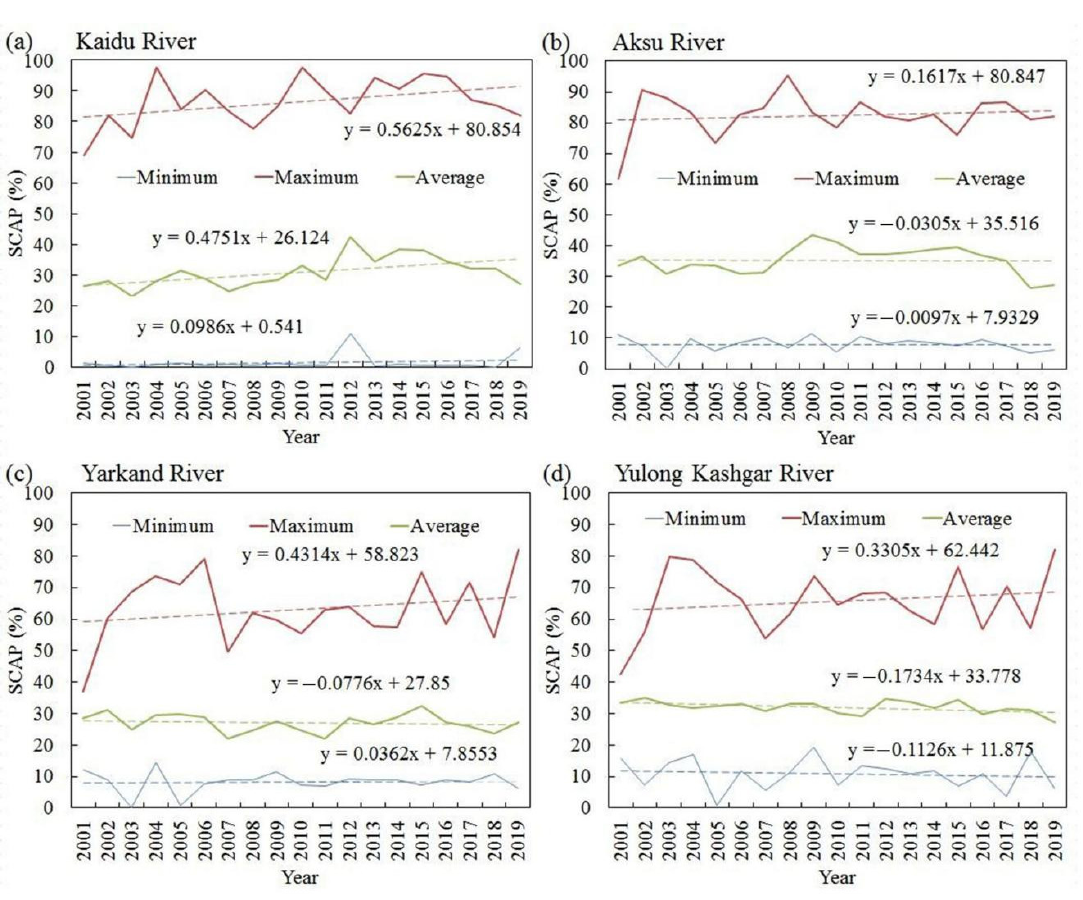
Figure 5. Variations of maximum, average, and minimum SCAP in the Tarim River Basin during 2001–2019.